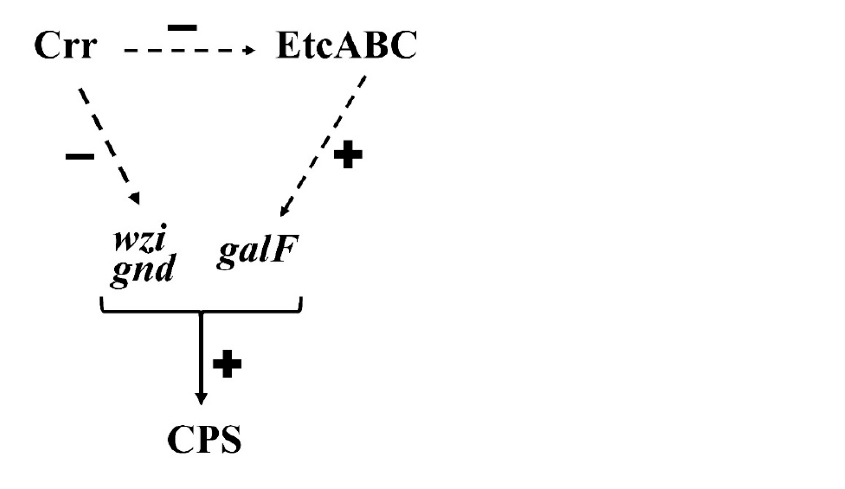
Figure 6. Model for the roles of Crr and EtcABC in the regulation of CPS synthesis in K. pneumoniae . Crr affects activity of EtcABC negatively but EtcABC affects the transcriptional activity of galF positively. In addition, Crr affects transcriptional activity of wzi and gnd negatively. The roles of galF , wzi and gnd are involved in CPS synthesis in K. pneumoniae . (+) and ( − ) represent positive and negative regulation respectively. Arrows with dashed line mean indirect regulation.